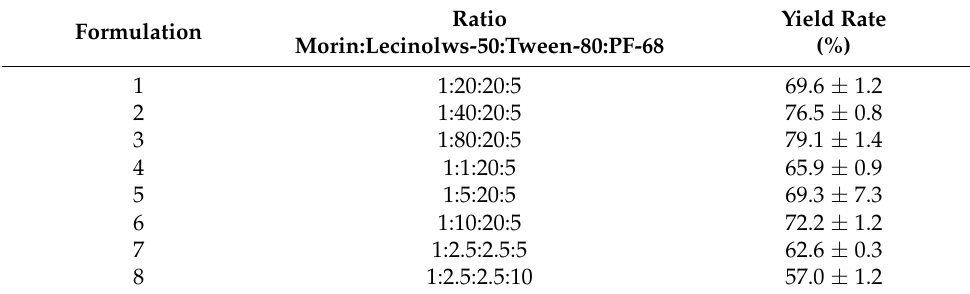
Table 4. Yield rate of liposomal morin preparation.